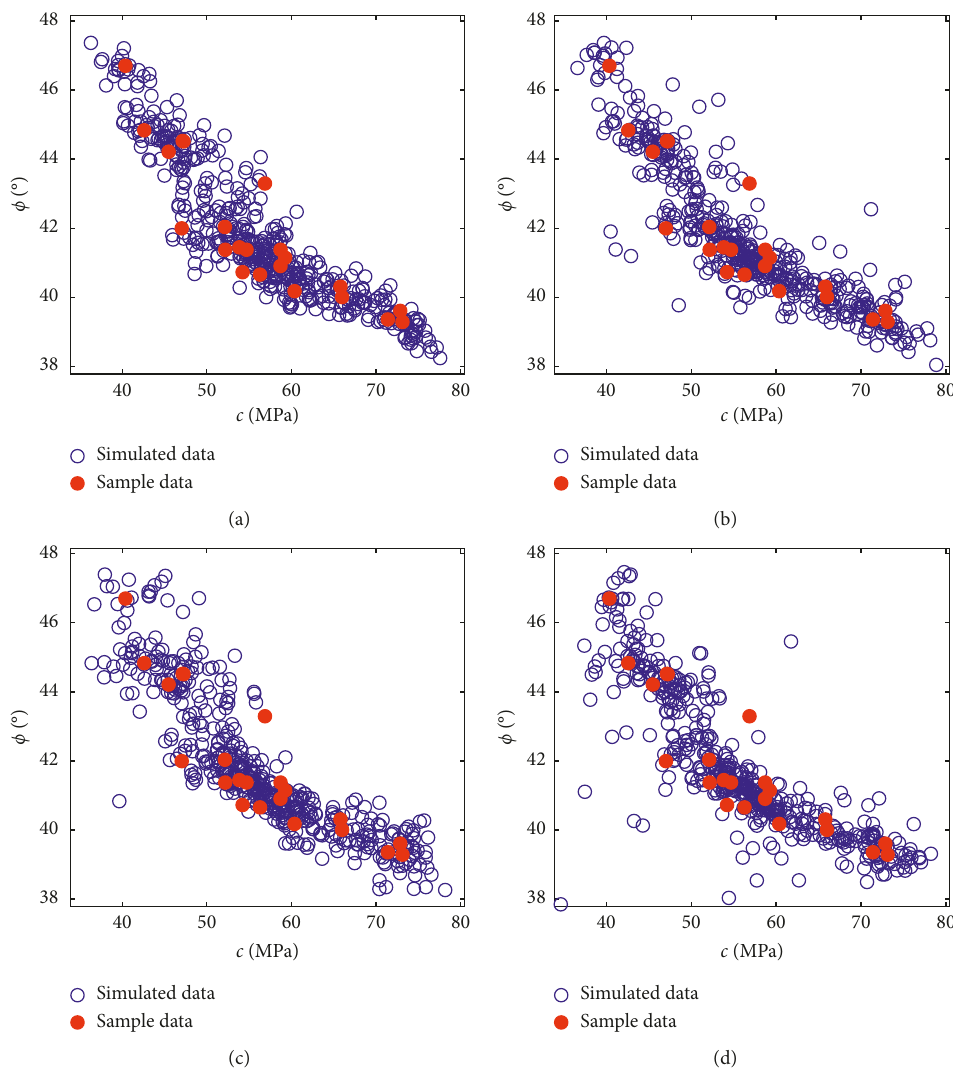
Figure 9: Scatter plots of equivalent samples generated by different copulas coupling ID margins. (a) Gaussian copula. (b) Plackett copula. (c) Frank copula. (d) No. 16 copula. Table 7: Parameters of different marginal distributions coupling Gaussian copula. Copula